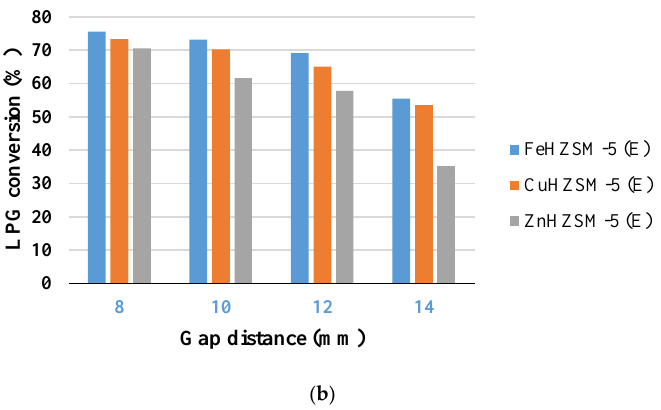
Figure 10. Effect of gap distance in oxidative dehydrogenation for FeHZSM-5, CuHZSM-5 and ZnHZSM-5 catalysts on ( a ) Olefin yield; ( b ) LPG conversion: 100 mg catalyst, 625 °C, 6 mA, and 4 wt. % metal loading.